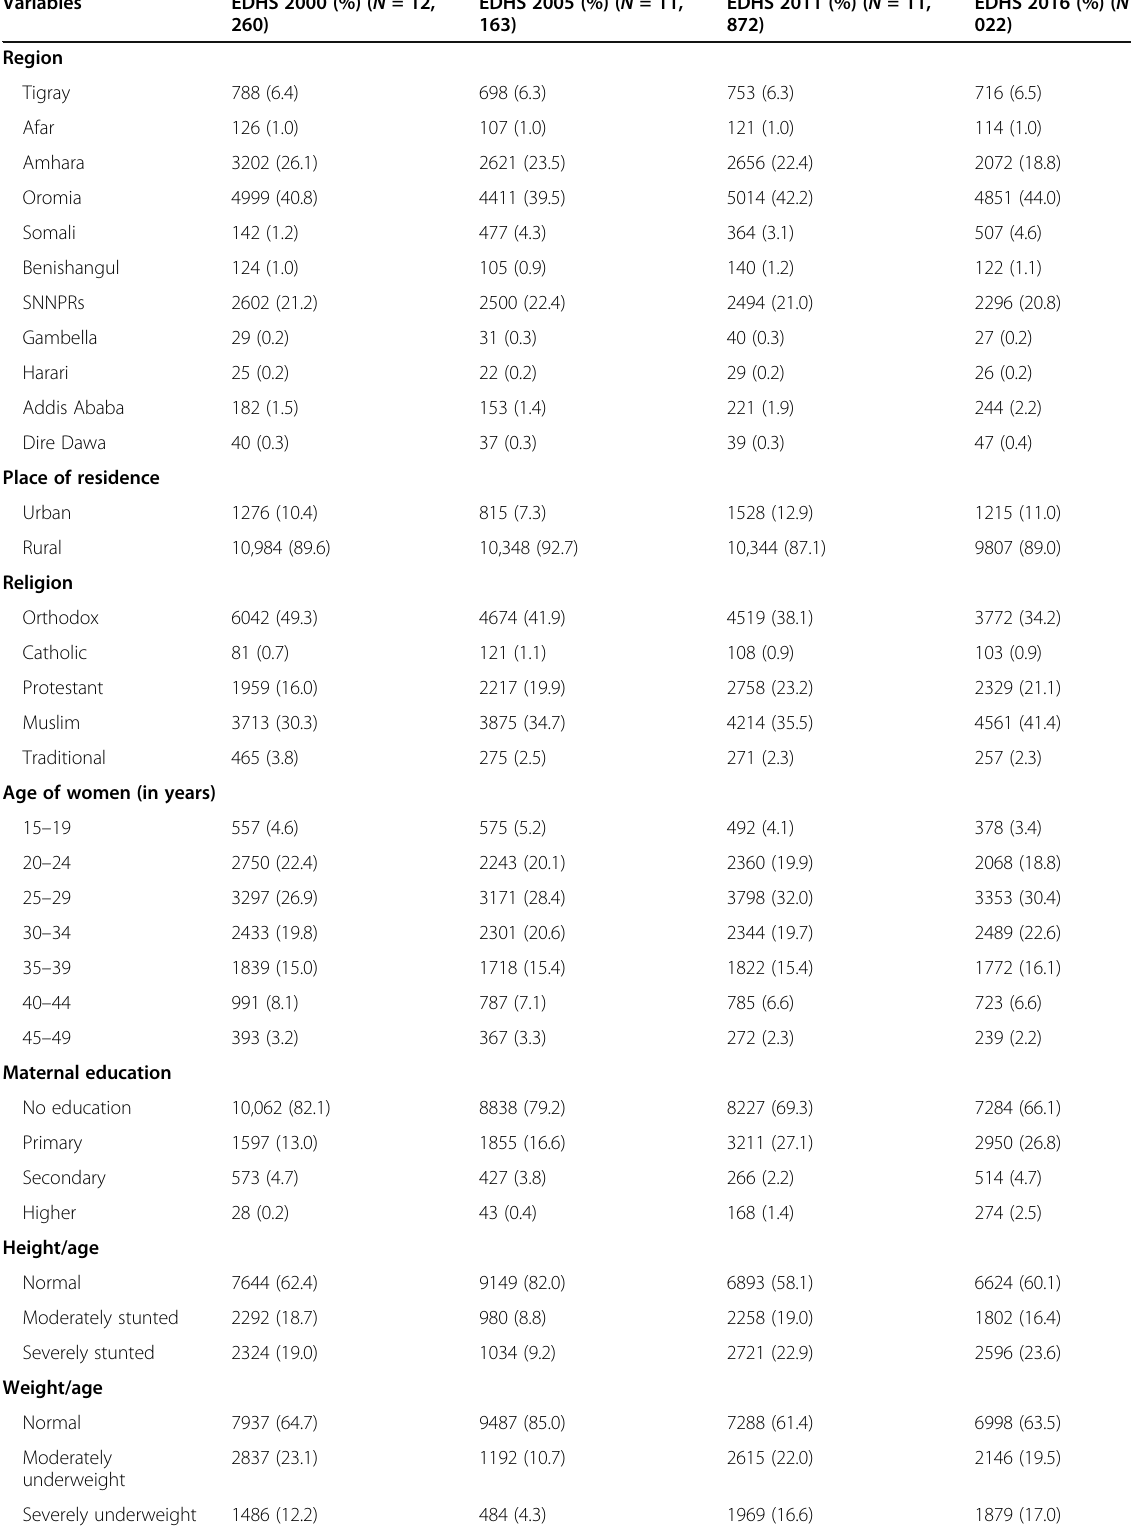
Table 1 Percentage distribution of characteristics of respondents in 2000, 2005, 2011, and 2016 Ethiopian Demographic and Health